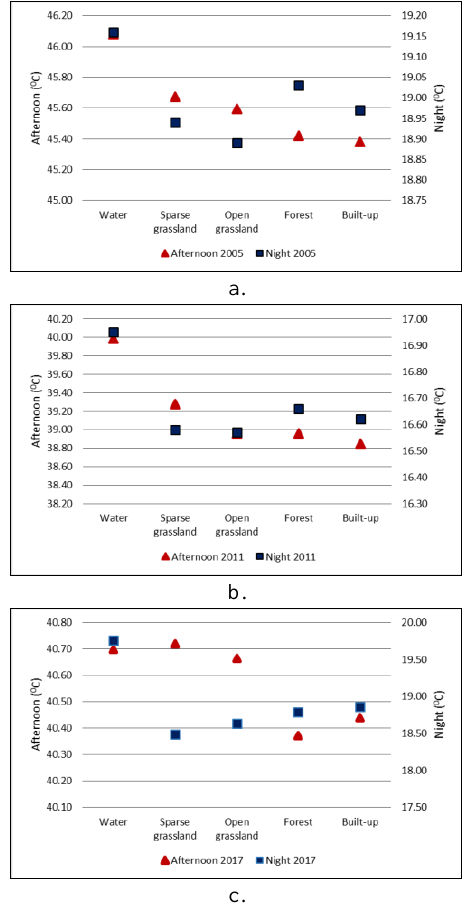
Figure 6: Mean LST of land cover from 1986 to 2017 Mean afternoon and night LST extracted from MODIS imagery indicated a decrease in LST from the year 2000 to 2017 (Table 5).